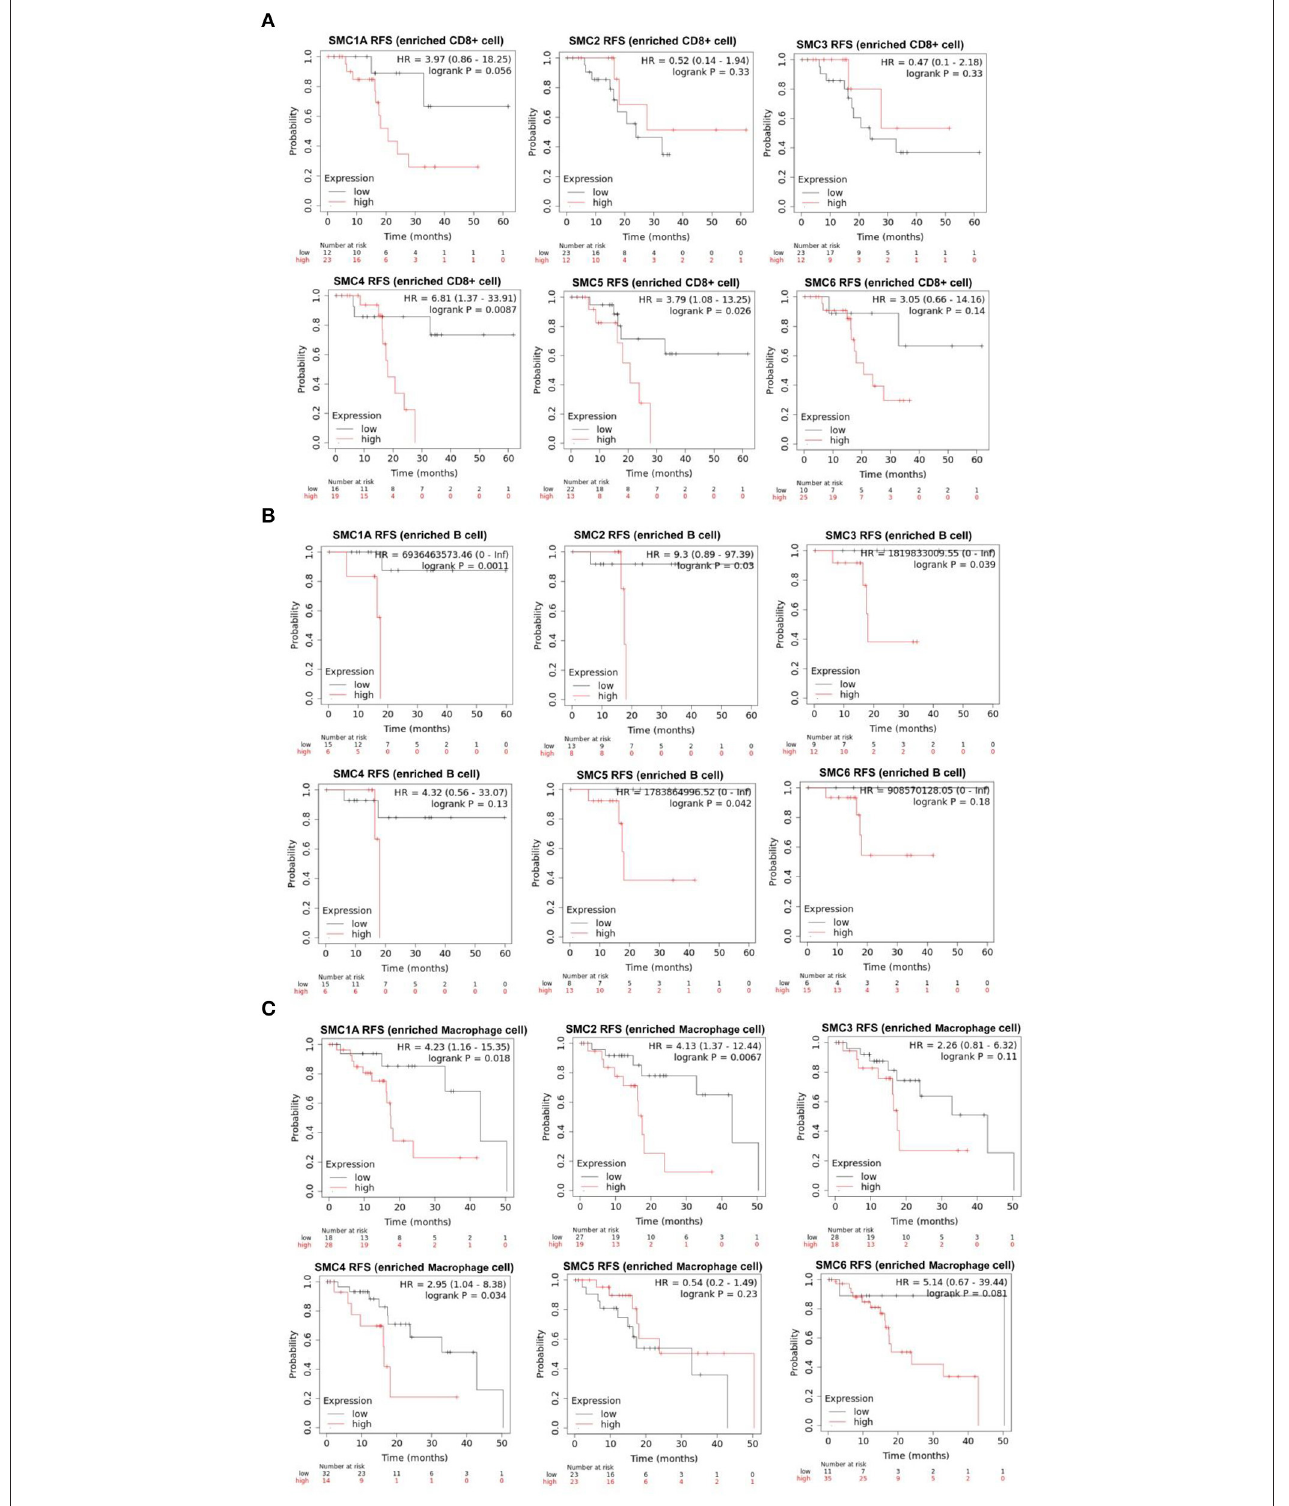
FIGURE 8 | mRNA expression levels of SMC family genes in PAAD are associated with recurrence-free survival (RFS). Relationships between the expression levels of SMC family genes and the RFS of PAAD patients enriched with (A) CD8 + T cells, (B) B cells, and (C) macrophages.